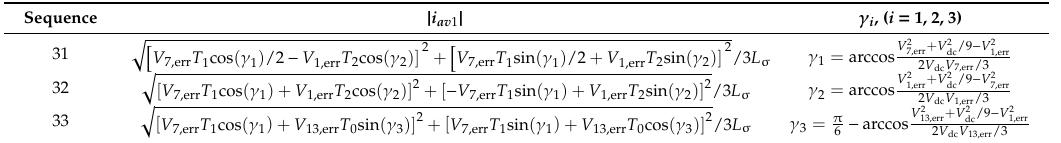
Table 1. The expression of | i av1 | in Triangle 3 (cid:79) of Sector Z